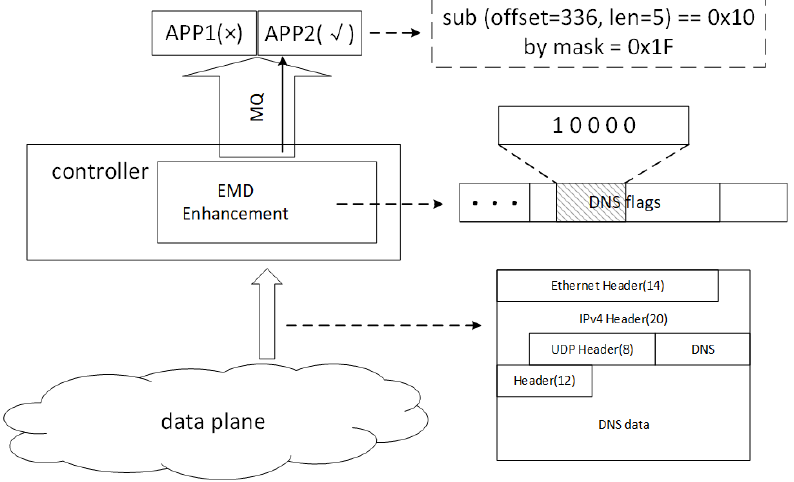
Figure 4. Distribution Mechanism by Protocol-irrelevant